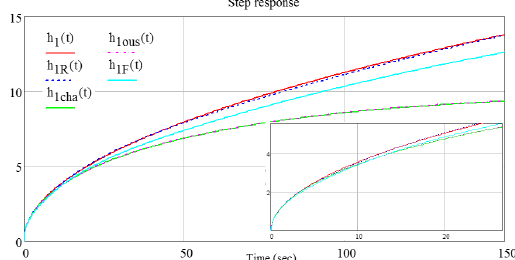
Fig. 7: Time responses